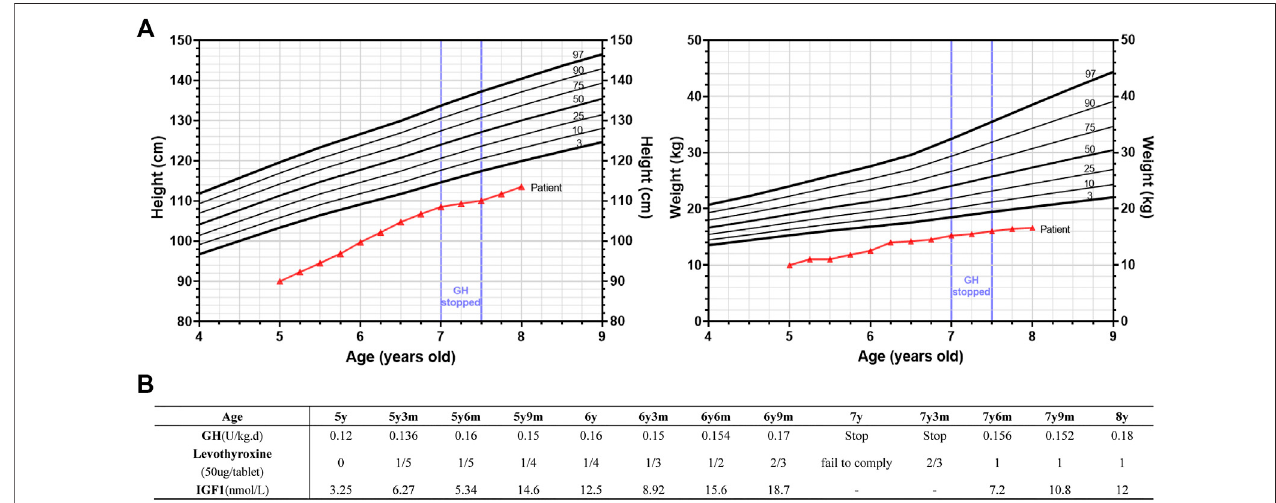
FIGURE2| Growthofthepatient ’ sheightandweightduringgrowthhormone(GH)andadjuvantlevothyroxinetreatment. (A) Heightandweightstandarddeviation curveofChinese4 – 9 yearsoldboysandthegrowthtrendoftheheight(leftpanel)andweight(rightpanel)ofthepatientfrom5y(yearsold)to8y.Thegrowthcurveofthe patientwasindicatedinredlines.GHtreatmentwassuspendedfrom7yto7y6m(months)asindicated.Differentpercentiles(3rd,10th,25th,50th,75th,90th,and97th) were as indicated. (B) The dosage of GH and levothyroxine used, and the corresponding IGF1 levels during this period. GH treatment was suspended from 7y to 7y6m (months) and levothyroxine was added as an adjuvant therapy when TSH reached 7.77 μ IU/ml after 3 months of GH